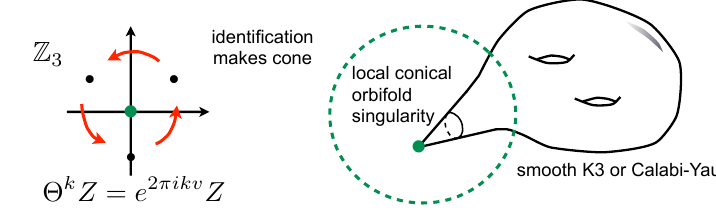
N creates a conical singularity. The